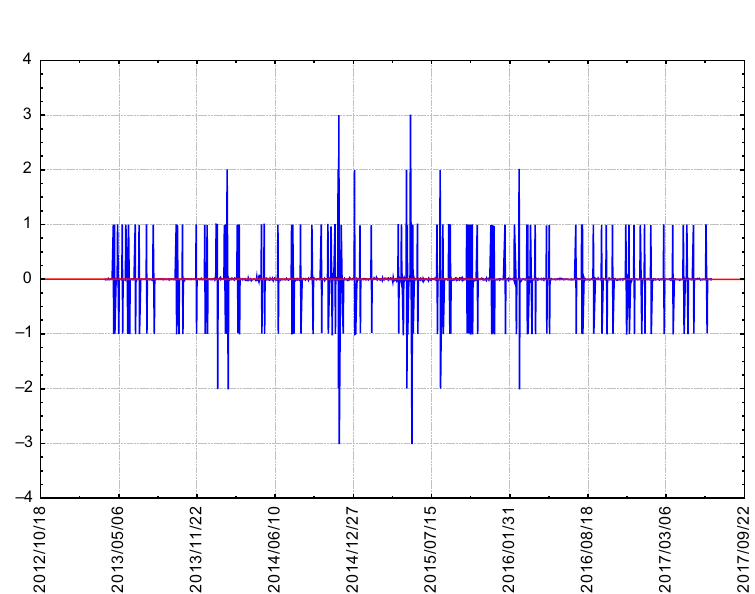
Figure 10. The conditional volatilities of the natural gas futures in the presence of OPEC news over the period